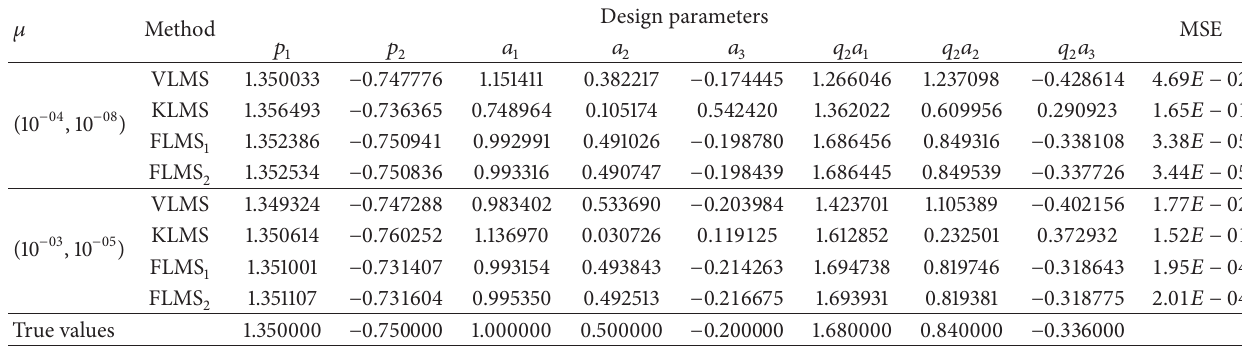
Table 8: Comparison of proposed results against true values of INCAR model for 3dB